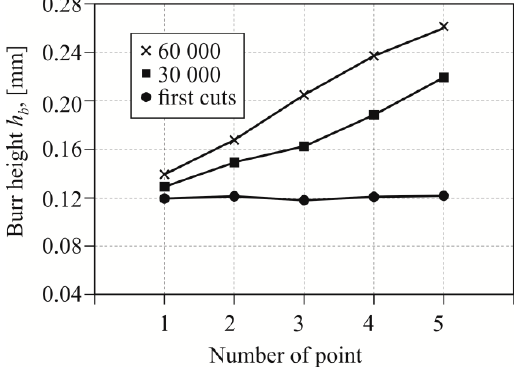
Figure 15. Burr height values measured along the blanking edge for five measuring points ( C = 5%).